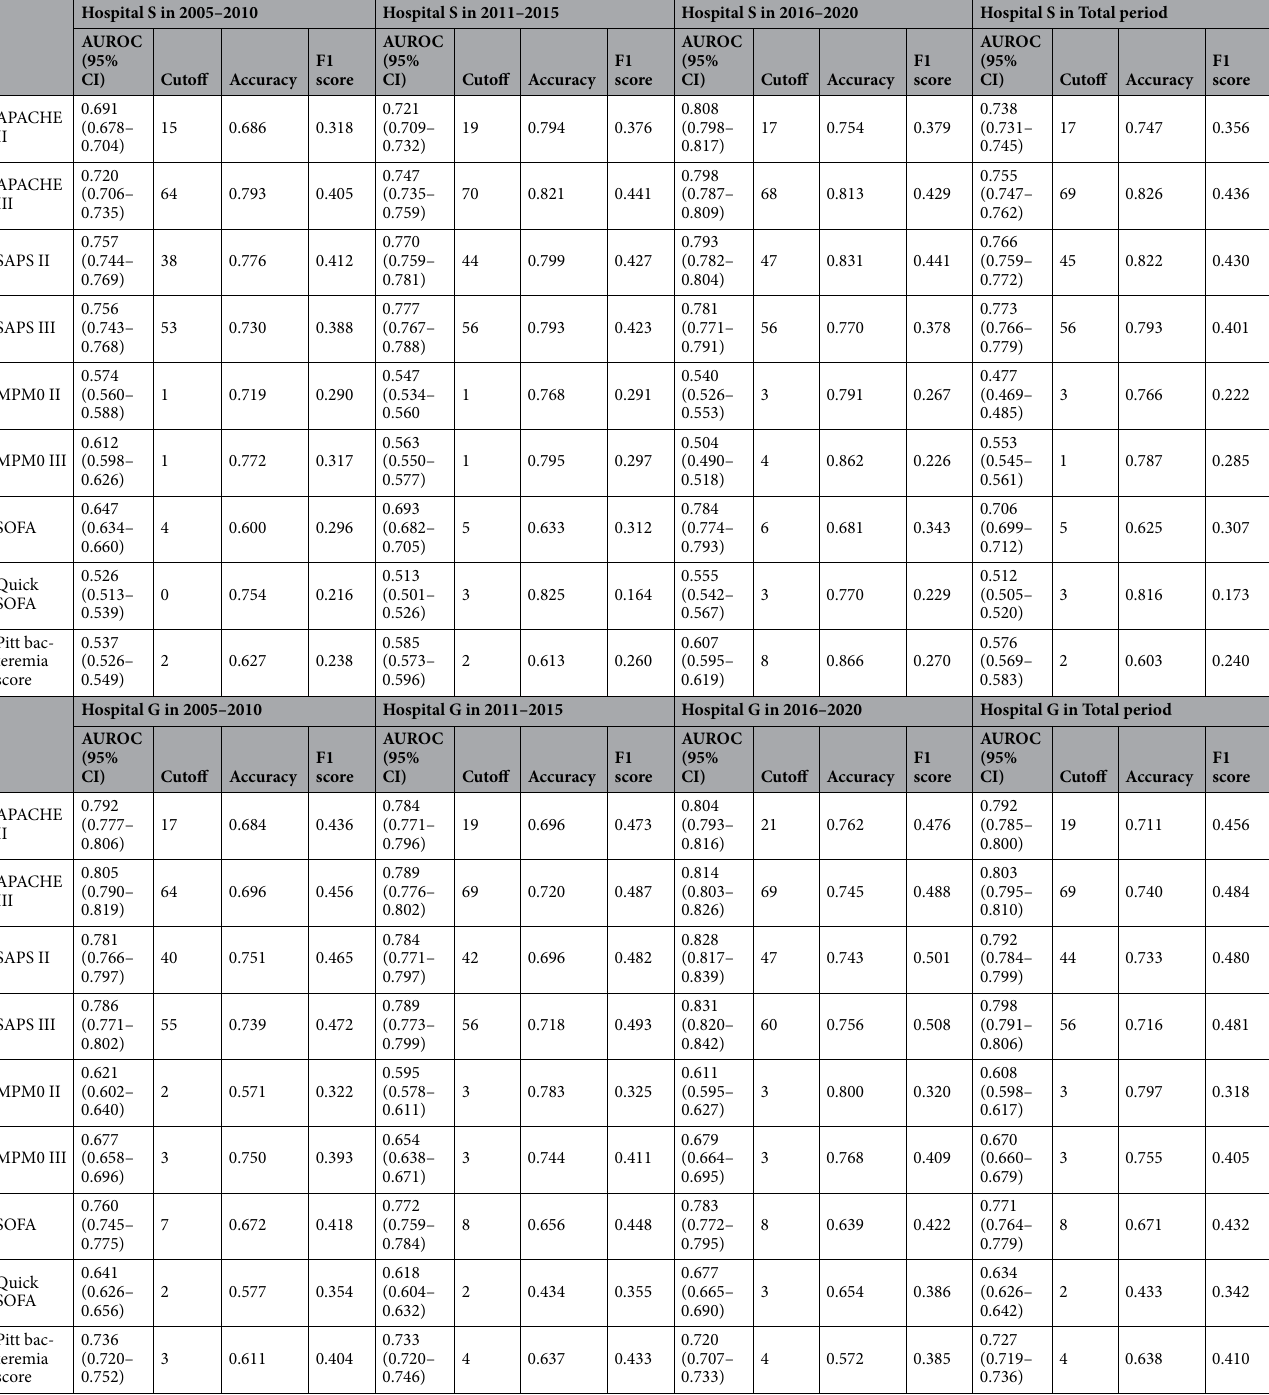
Table 2. Performance metrics for the conventional scoring systems by hospital and study period. AUROC area under the receiver operating characteristic curve, APACHE Assessment and Chronic Health Evaluation, SAPS Simplified Acute Physiology Score. MPM Mortality Probability Model, SOFA Sequential Oran Failure